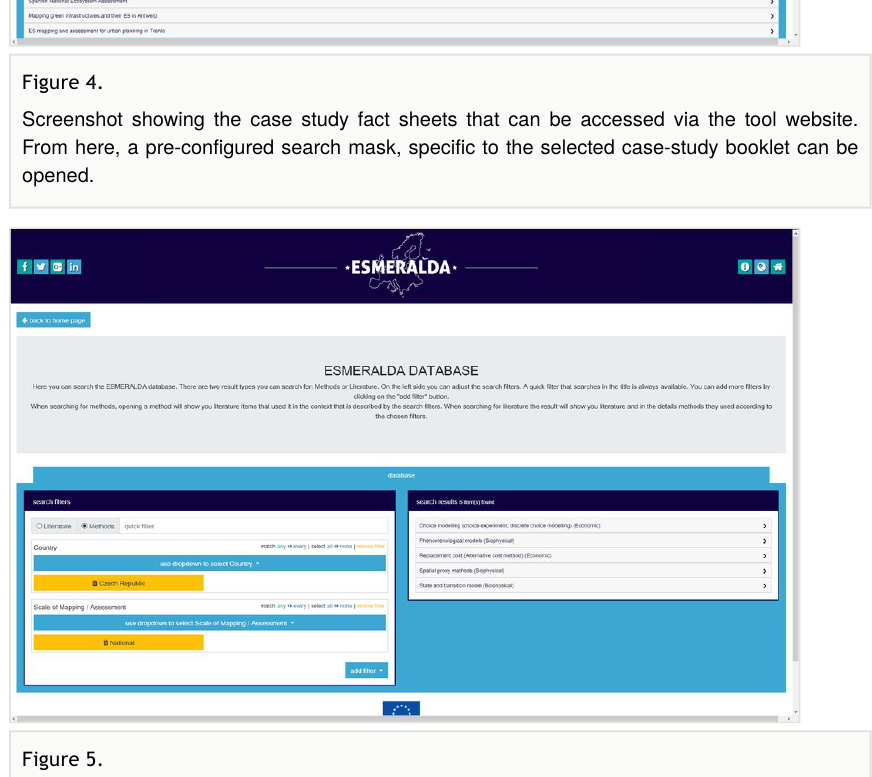
Figure 5. Tailoring down results of methods used at national level in Czech